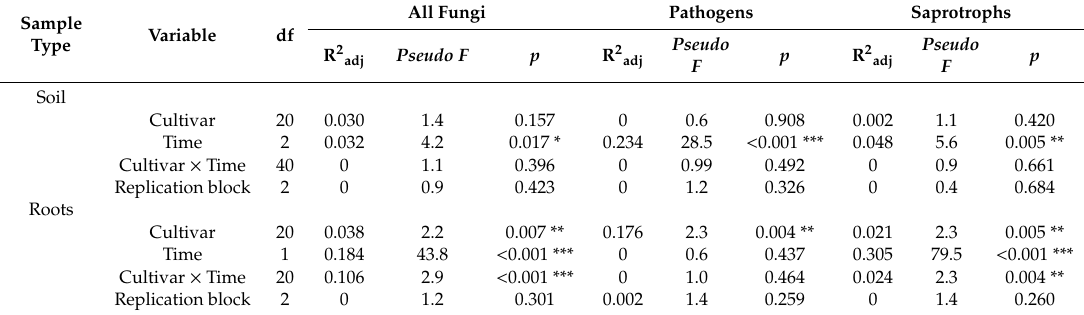
Table 1. E ff ects of cultivar, sampling time, and cultivar × sampling time interaction on the richness of all fungi, saprotrophic fungi, and plant pathogenic fungi in soil and